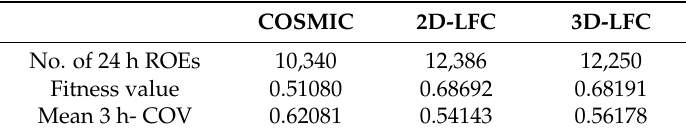
Table 7. The comparison of the performances of the optimized six-satellite 2D-LFC, 3D-LFC with